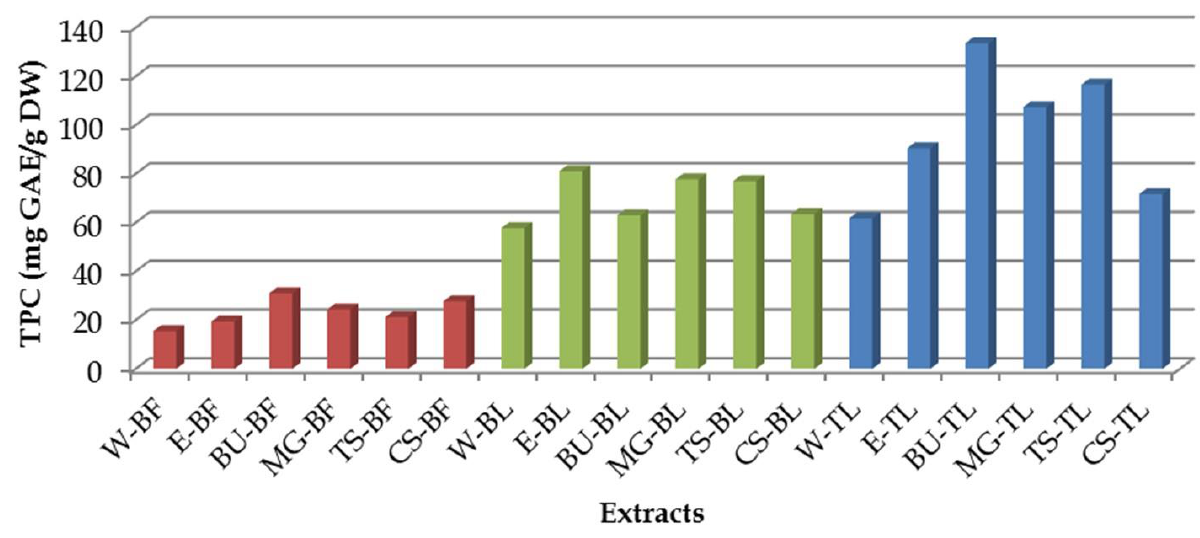
Figure 1. Total phenolic content (TPC) in the investigated extracts (the abbreviations are listed in Table